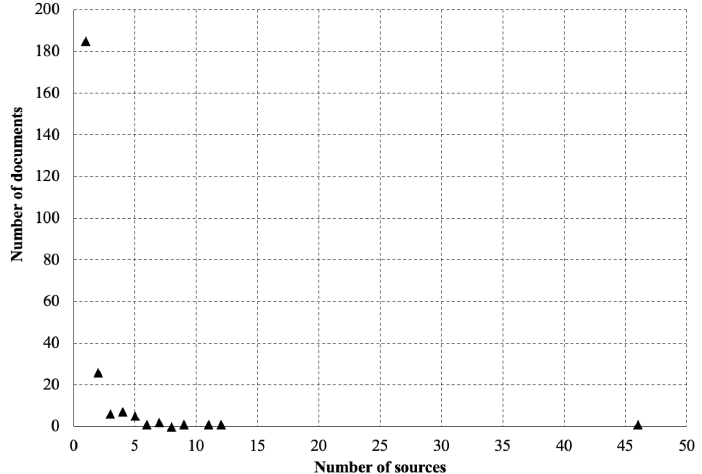
Figure 3. Relationship between number of sources and documents